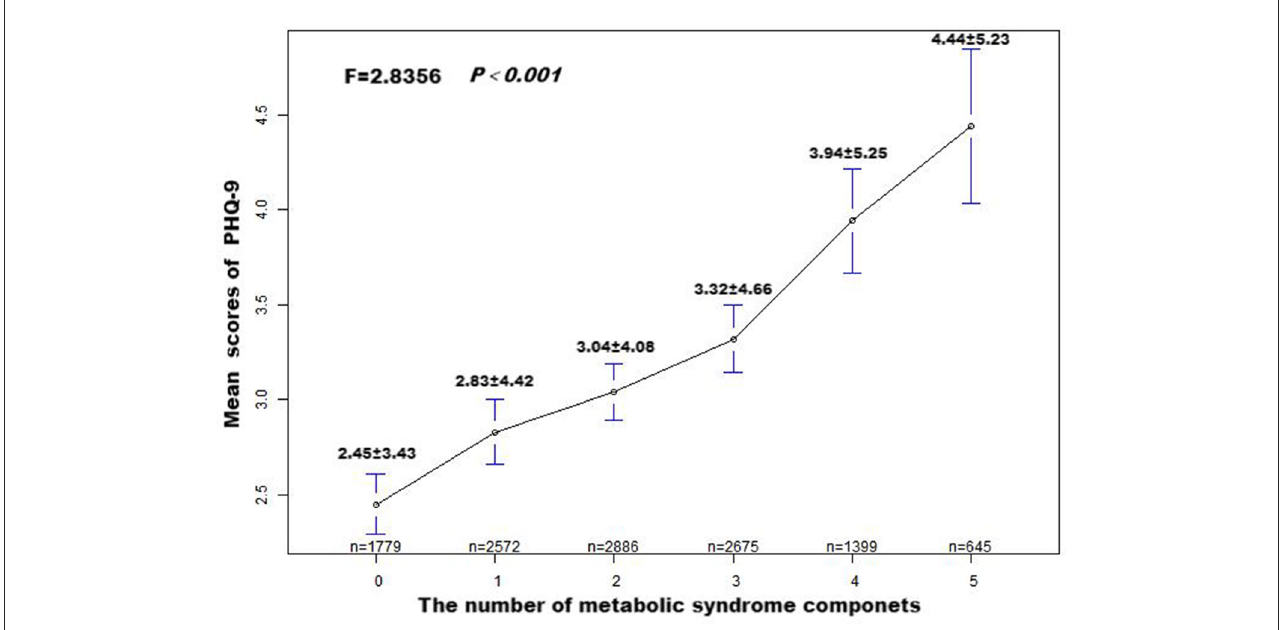
FIGURE2 Patient Health Questionnaire-9 (PHQ-9) means score and standard error, according to the number of metabolic syndrome components. P -values were obtained by Fisher’s exact test.